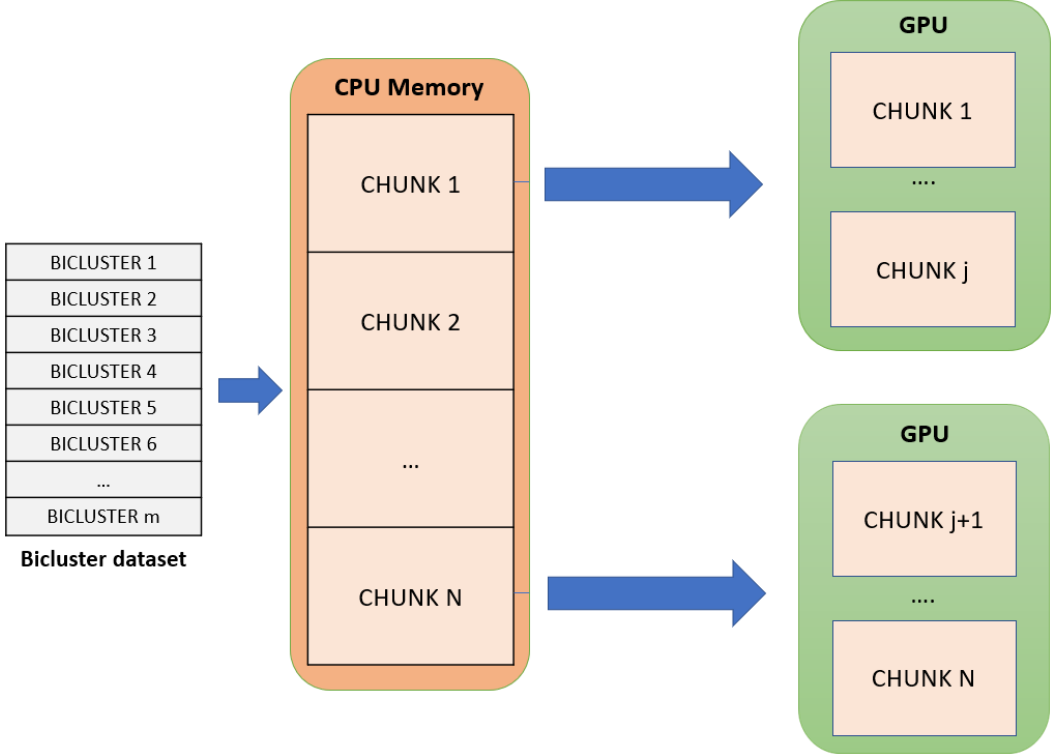
Figure 2. The distribution of the input biclusters dataset is shown. It is divided into multiple